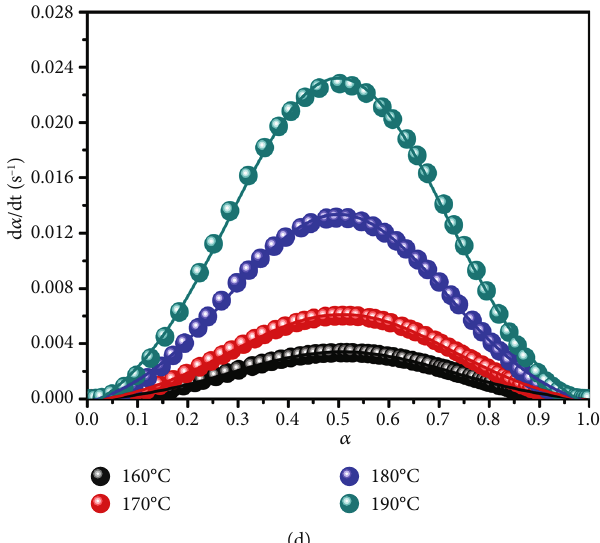
Figure 4: The autocatalytic properties of the compositions: (a) cure rate of conversion (d α /d t ) as a function of (b) d α /d t at cure time (minutes), (c) d α /d t versus the conversion ( α ) for NBR at160 ° C – 190 ° C, and (d) d α /d t versus the conversion ( α ) for NBR – GO-1 at 160 – 190 ° C.